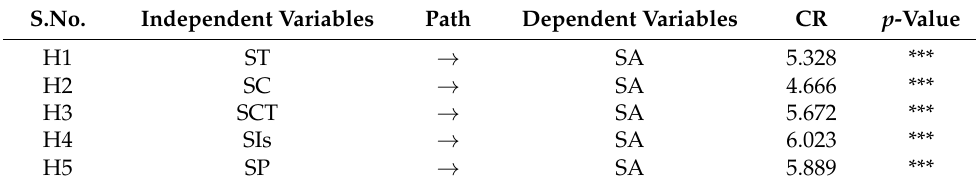
Table 4. SEM Estimations.